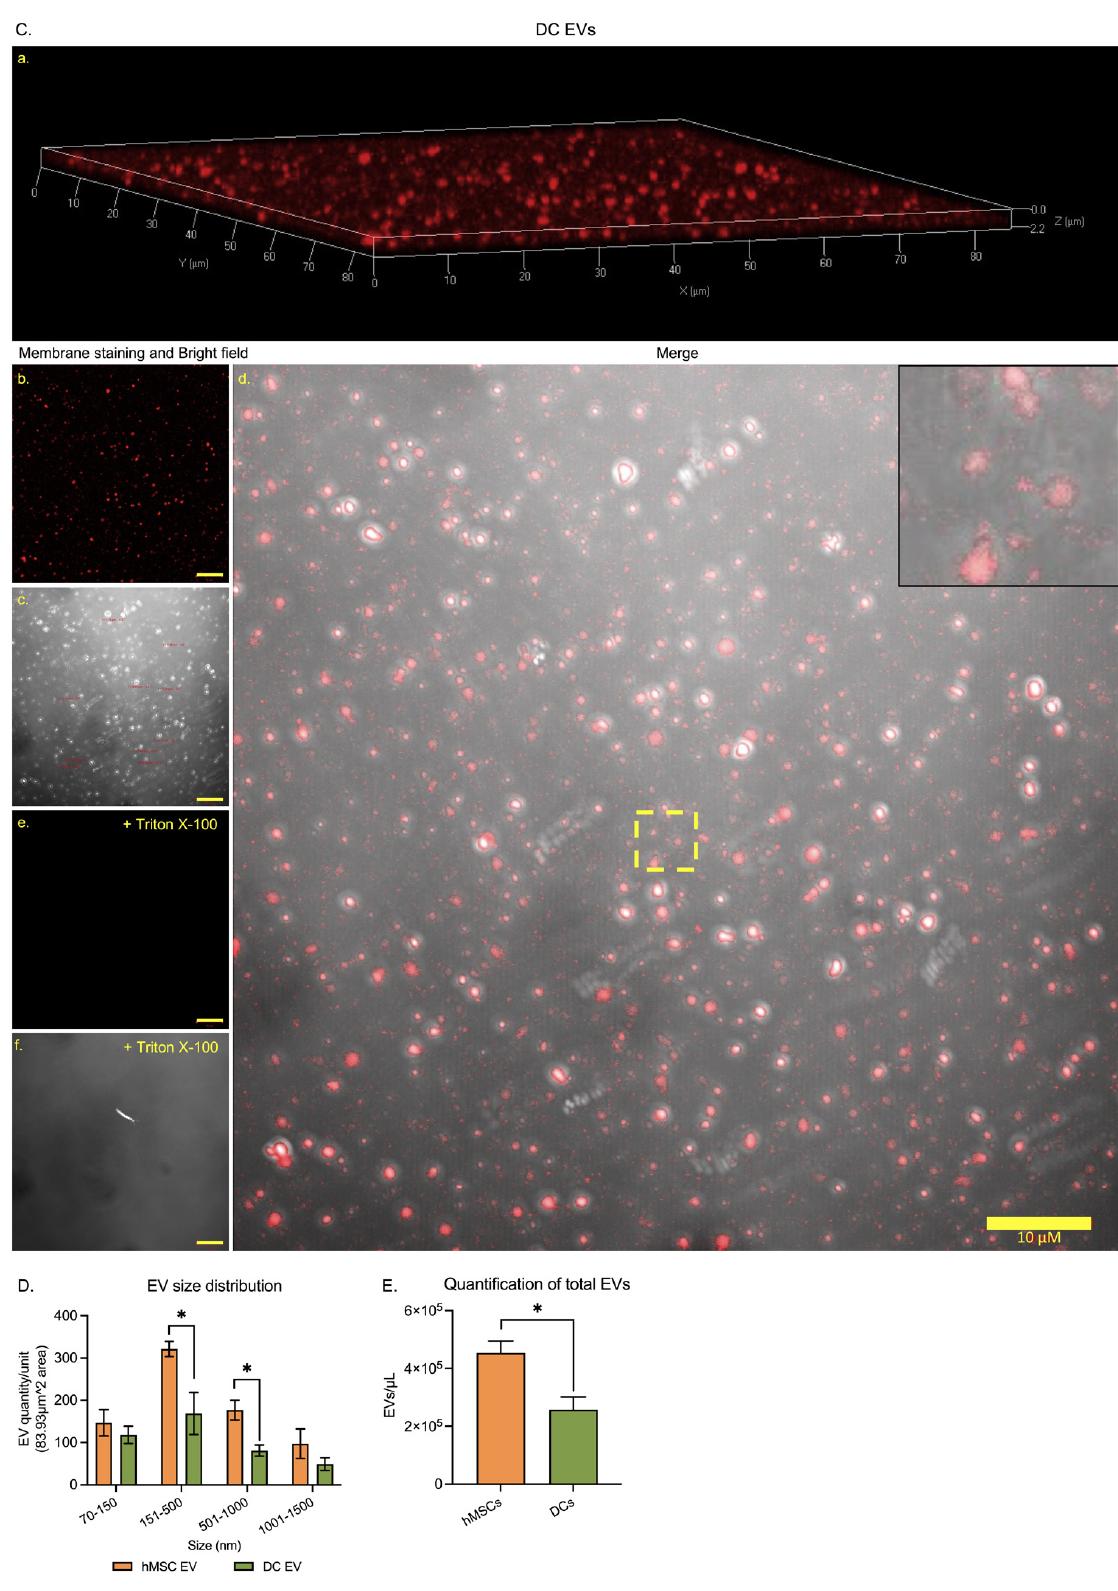
Figure 3. EV production by DiI-labeled hMSCs and DCs. ( A ) Representative images showing plasma membrane (red) ( A-a ), nuclear (blue) ( A-b ), and merge staining ( A-c ) of co-cultured unlabeled